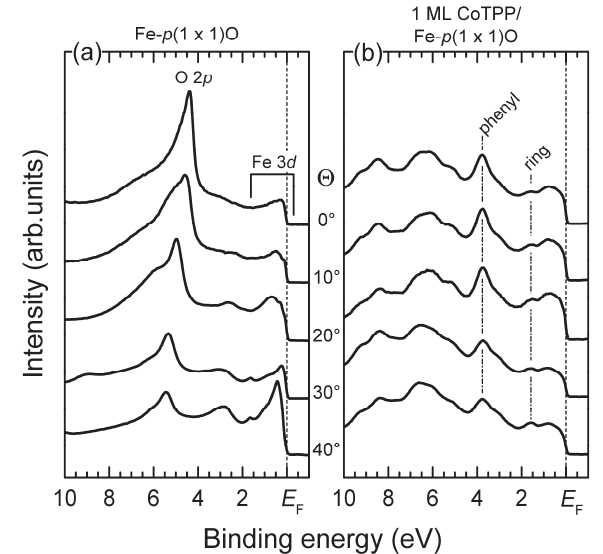
Fig. 5. Angle resolved UPS spectra from (a) Fe(001)- p (1 × 1)O (adapted from Ref. [25]) and (b) 1 ML CoTPP on Fe(001)- p (1 × 1)O. The spectra are collected by varying the polar angle of emission (Θ) from 0° (electron emitted along the surface normal) towards the ΓX direction of the surface point is reached for Brillouin zone. The X ���� � Fe(001)- p (1 × 1)O (Figure 5b) under the same